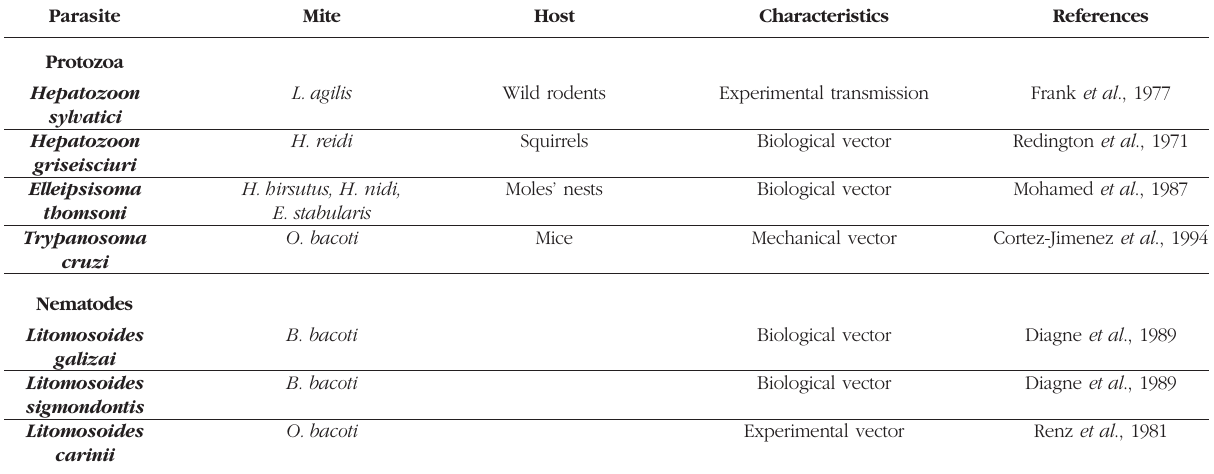
Table IV. – Parasites likely to be transmitted by dermanyssoid mites. ( B. bacoti = Bdellonyssus bacoti, E. stabularis = Eulaelaps stabularis, H. hirsutus = Haemogamasus hirsutus, H. nidi = Haemogamasus nidi, H. reidi = Haemogamasus reidi, L. agilis = Laelaps agilis, O. bacoti = Ornithonyssus bacoti ).